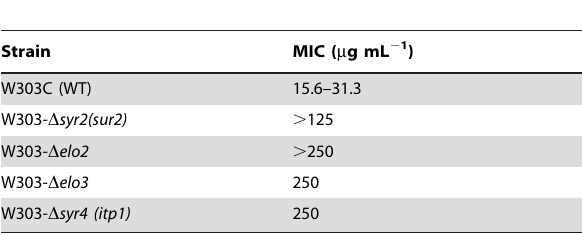
Table 1. Growth susceptibilities of yeast sphingolipid biosynthetic mutants to FG08.